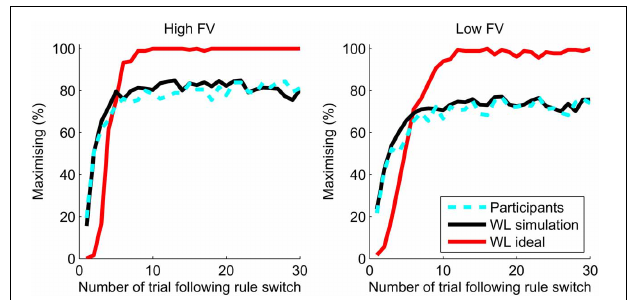
FIGURE 7 | Maximizing after a switch for the best parameters for the WL model (WL ideal, red line) compared to the percentage of maximizing responses by participants (dashed cyan line). The WL simulation uses parameters fit to each participant’s